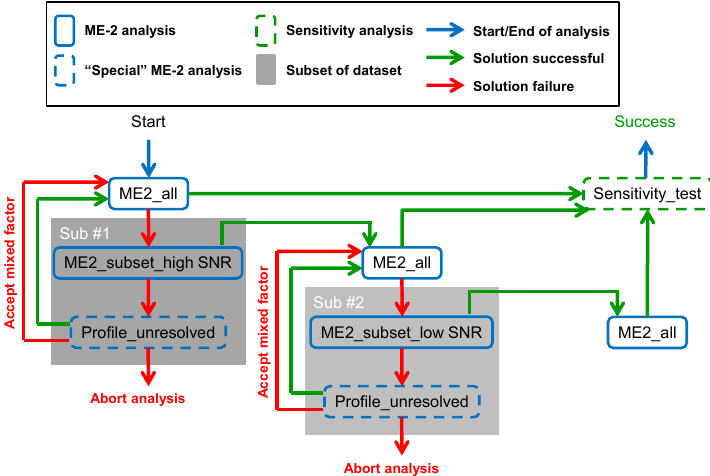
Figure 2. Schematic representation of the ME-2 analysis strategy. Four types of ME-2 analyses are represented: (1) ME-2 on entire data set (ME2_all), (2) ME-2 on a subset of data (ME2_subset, e.g. by high and low SNR), (3) profile determination or estimation of factors unresolv- able by ME2_all or ME2_subset (PROF_unresolved), and (4) sensitivity tests to quantify rotational model uncertainties (Sensitivity_test). For simplicity, we show a case where analysis of two subsets of the data set is sufficient to construct the source profile basis set but where in theory n segments can be used. See Supplement Fig. S5 for application to data sets used in this